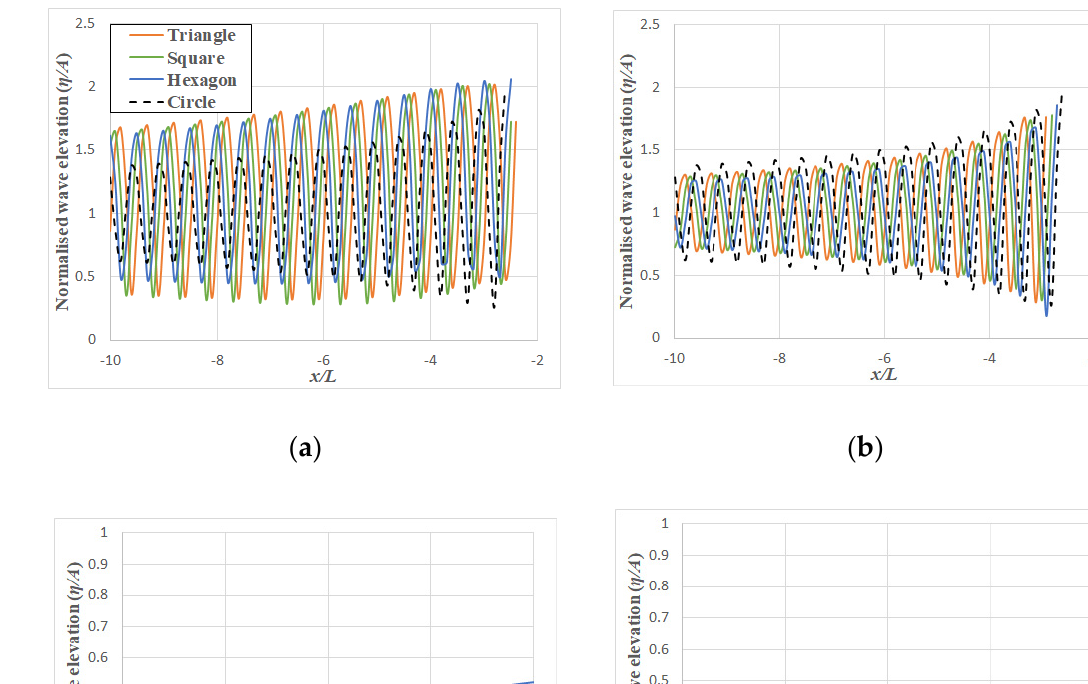
Figure 8. Wave fields for triangular, square, hexagonal, and circular platforms ( T = 5 s): ( a ) triangular platform (Case 1); ( b ) triangular platform (Case 2); ( c ) square platform (Case 1); ( d ) square platform (Case 2); ( e ) hexagonal platform (Case 1); ( f ) hexagonal platform (Case 2); and ( g ) circular platform.